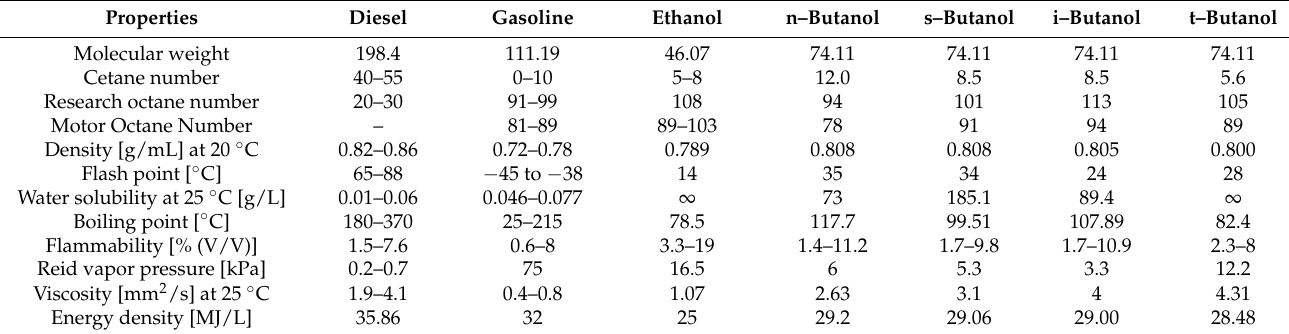
Table 1. Comparison of the properties of butanol isomers with other conventional fuels